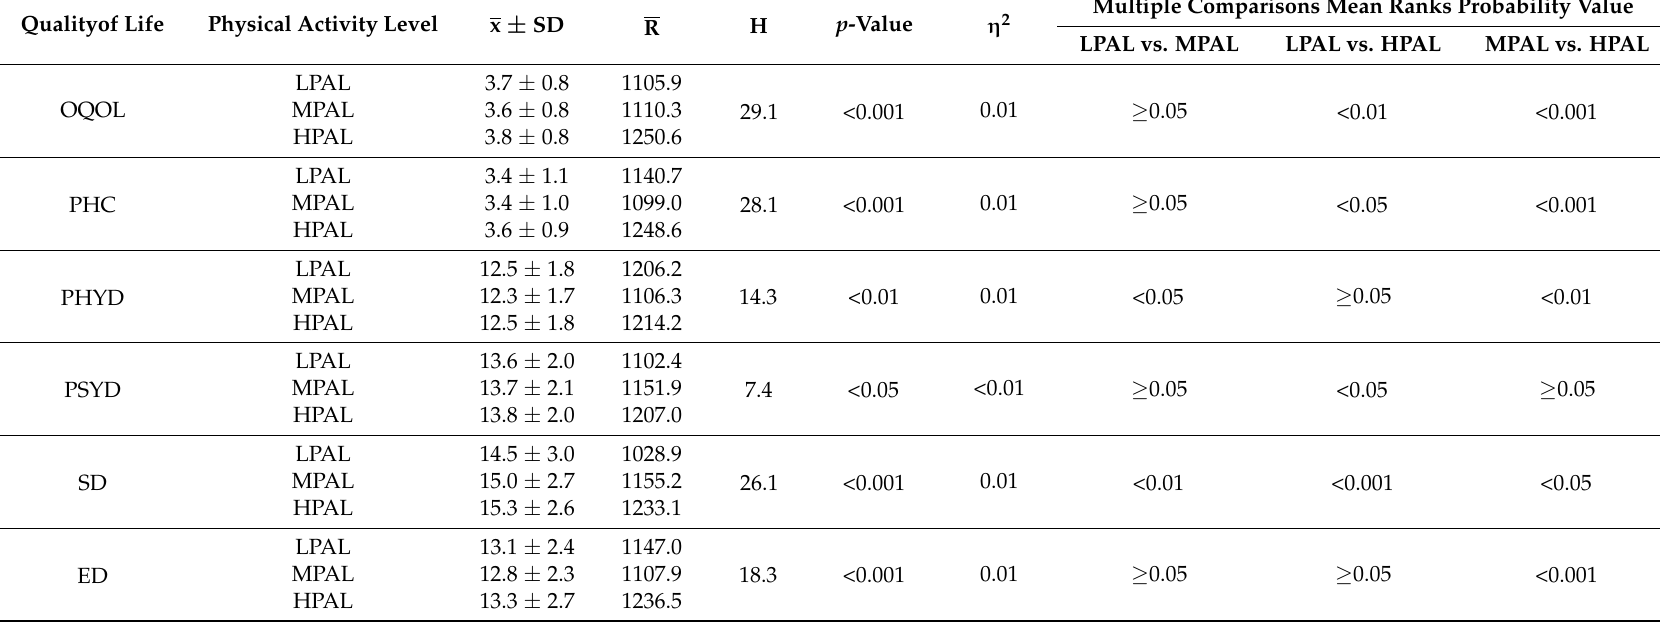
Table 3. Quality of life in groups of women with different levels of physical